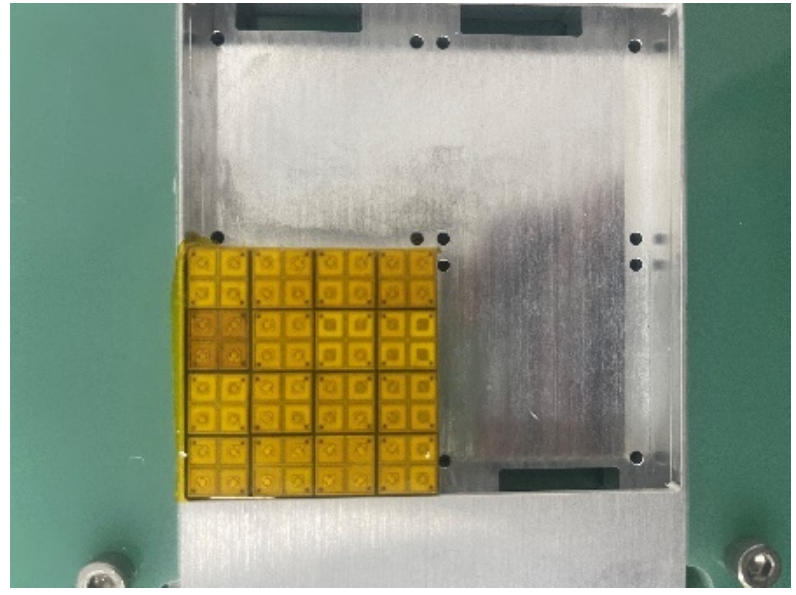
Figure 8. A 64-element planar phased array antenna.